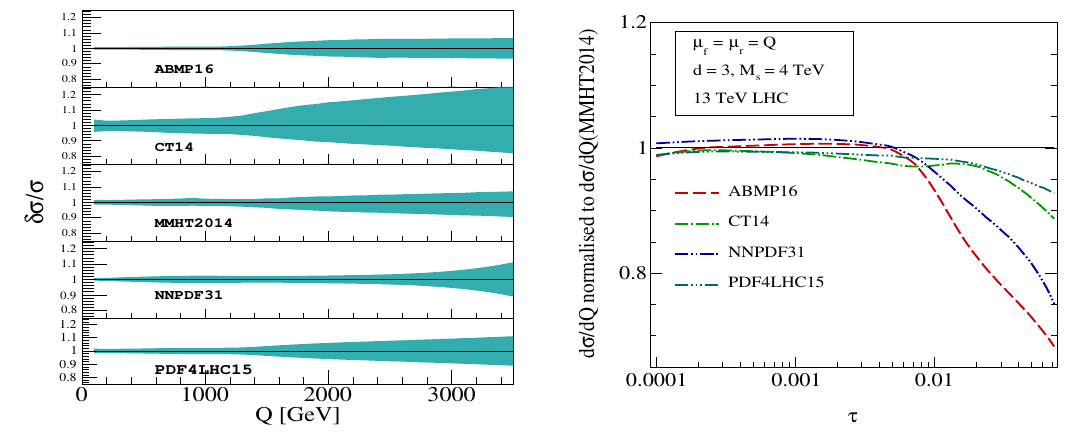
Figure 13 . The intrinsic PDF uncertainties for di(cid:11)erent PDF groups at NNLO+NNLL order are shown in the left panel as a function of the di-lepton invariant mass Q . In the right panel, the invariant mass distributions for di(cid:11)erent PDF groups at NNLO+NNLL order (computed with central set) normalized with that obtained from the default choice MMHT2014nnlo PDF